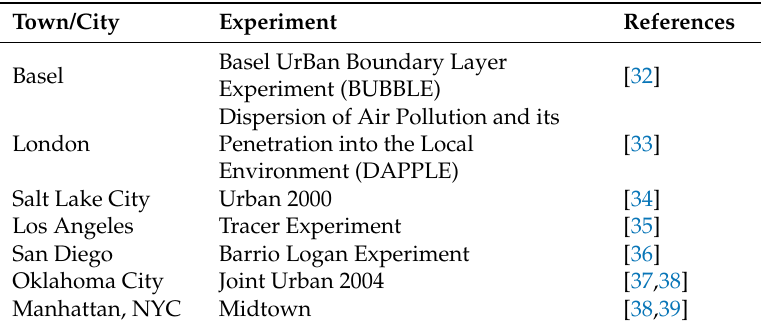
Table 4. Significant urban dispersion field